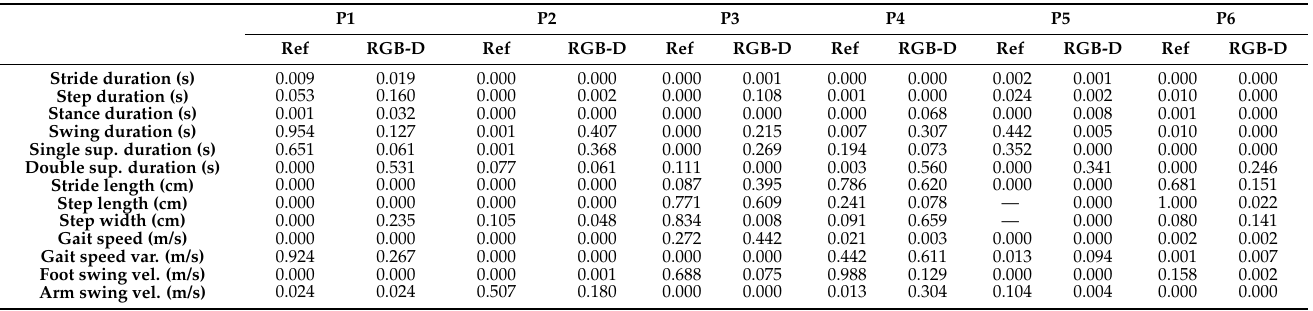
Table A3. p -value obtained on the Mann–Whitney U test for the difference between the mean value at T1 and T0, for each parameter, patient, and system (“Ref” stands for reference system and “RGB-D” for RGB-D camera-based